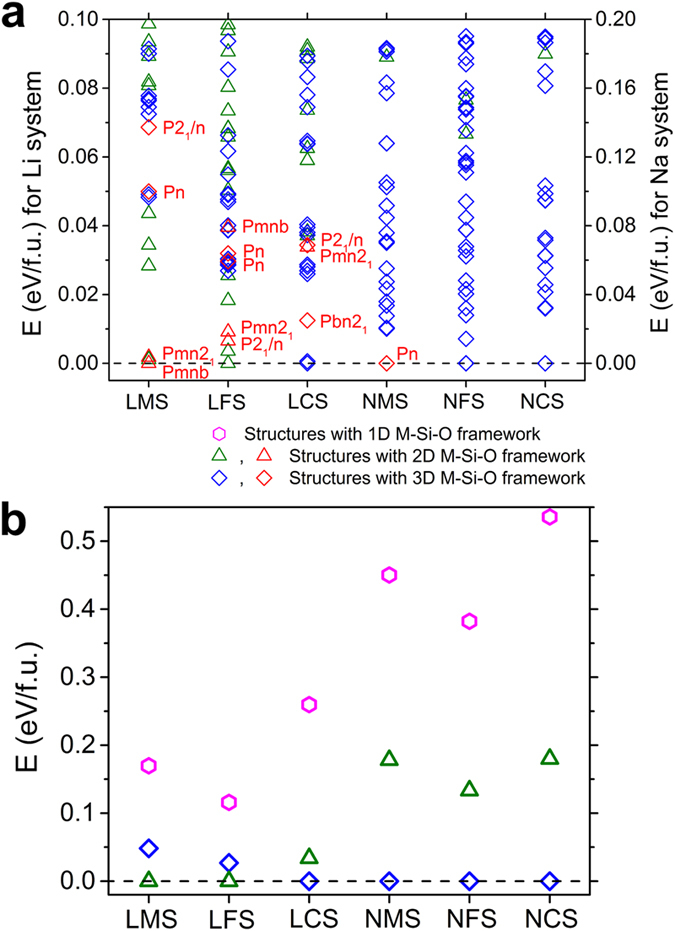
Energetics results.(a) Relative energies of the structures obtained in this work for Li2MnSiO4 (LMS), Li2FeSiO4 (LFS), Li2CoSiO4 (LCS) and Na2MnSiO4 (NMS), Na2FeSiO4 (NFS), Na2CoSiO4 (NCS). Triangles (green) indicate the structures with layered 2D-framework and diamonds (blue) indicate the structures with 3D M-Si-O framework. Structures that have been reported in the literature are shown in red color and also labeled by their space groups. For the two LFS Pn phases, the lower-energy one corresponds to the Pmn21-cycled phase with 2 formula units and the higher-energy one corresponds to the P21/n-cycled phase with 4 formula units. (b) Relative energies of the most stable structures with 3D, 2D and 1D M-Si-O framework for each system. Energy of the ground state structure for each system is set to 0 eV as reference in (a,b).